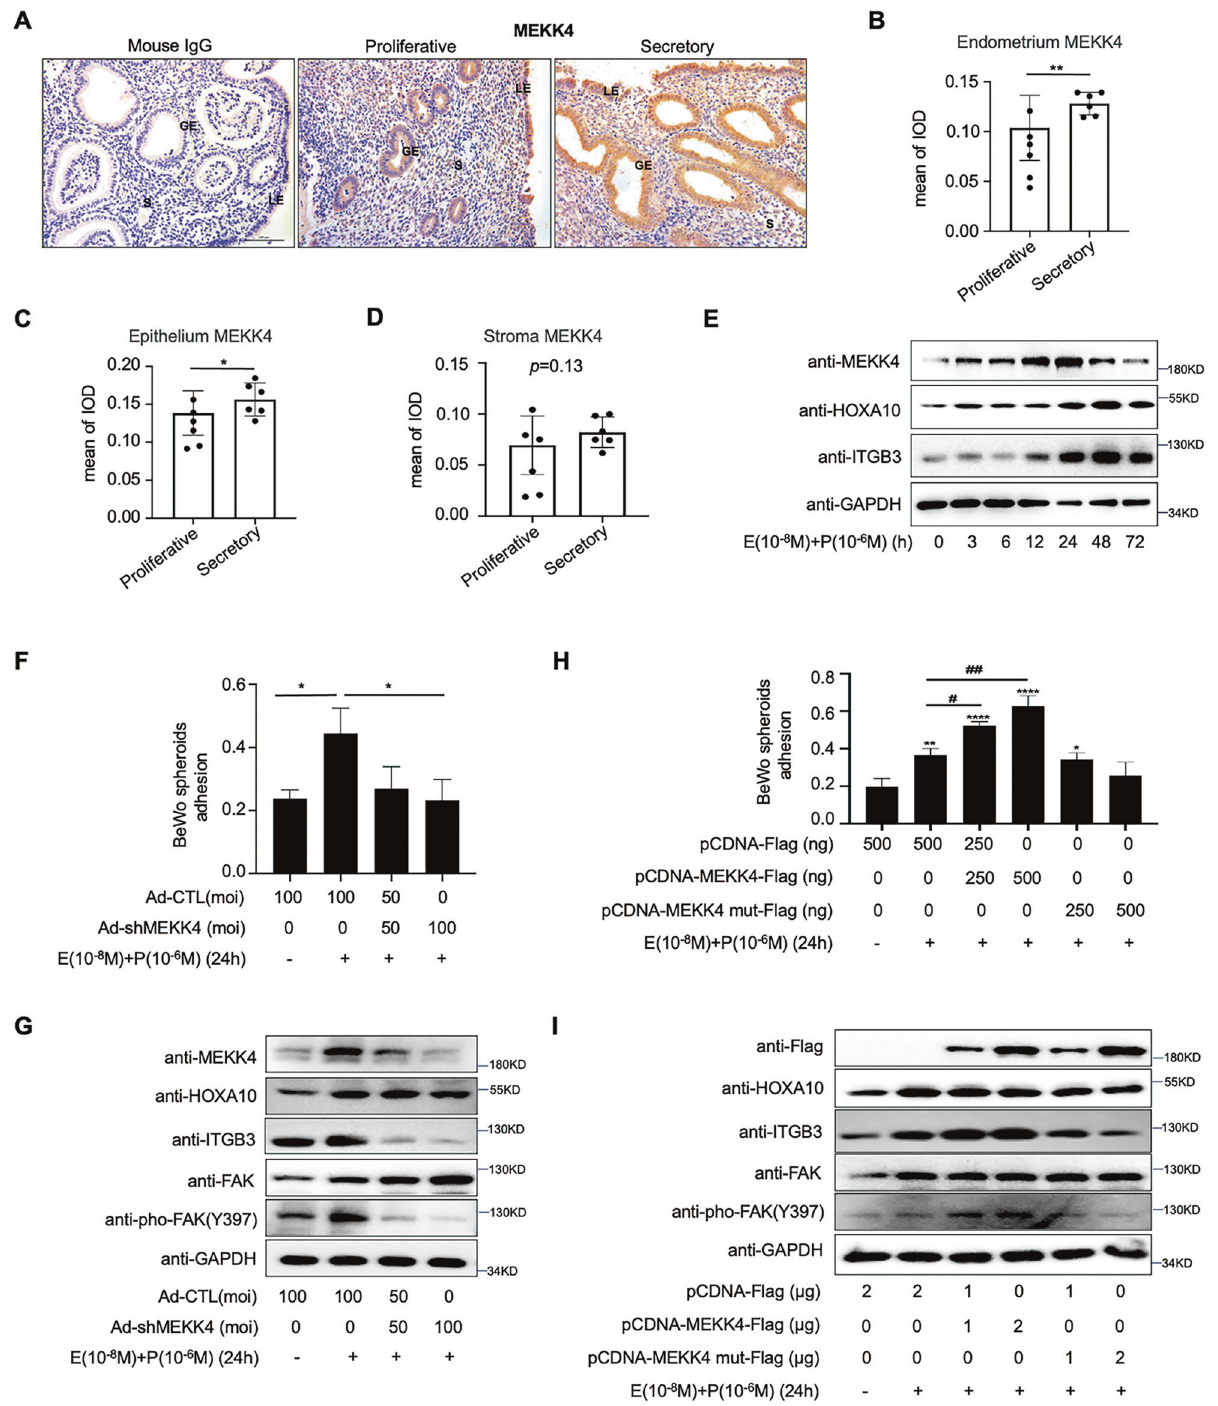
Fig. 3 MEKK4 is mainly expressed in the endometrial epithelium and promotes embryo adhesion. A – D Immunohistochemical analysis of the MEKK4 expression in proliferative ( n = 6) and secretory ( n = 6) endometria from normal fertile women. Mouse IgG was used as a negative control. Data are represented as mean ± SEM, * P < 0.05, ** P < 0.01, using t -test. (Scale bar = 100 µm). E Western blotting analysis of MEKK4, HOXA10, and ITGB3 expression in Ishikawa cells treated with E 2 and MPA as indicated. F In vitro adhesion experiments analysis of the effect of MEKK4 knockdown on BeWo adhesion attached to the monolayer of Ishikawa cell. Values represent the mean ± SEM ( n = 3); * P < 0.05, using one-way ANOVA. G Western blotting analysis of MEKK4, HOXA10, ITGB3, FAK, and pho-FAK expression in Ishikawa cells treated with the adenovirus Ad-shMEKK4 and then stimulated with E 2 and MPA for 24 h. H In vitro adhesion experiments analysis of the effect of MEKK4 overexpression and kinase inactivation on BeWo adhesion attached to the monolayer of Ishikawa cell. Values represent the mean ± SEM ( n = 3); **** P < 0.0001; ** P < 0.01; * P < 0.05 compared with the pCDNA-Flag group; ## P < 0.01; # P < 0.05, using one-way ANOVA. I Western blotting analysis of MEKK4, HOXA10, ITGB3, FAK, and pho-FAK expression in Ishikawa cells transfected with MEKK4-Flag and MEKK4 mut-Flag (K1372R, kinase inactivation) and then treated with E 2 and MPA for 24 h.